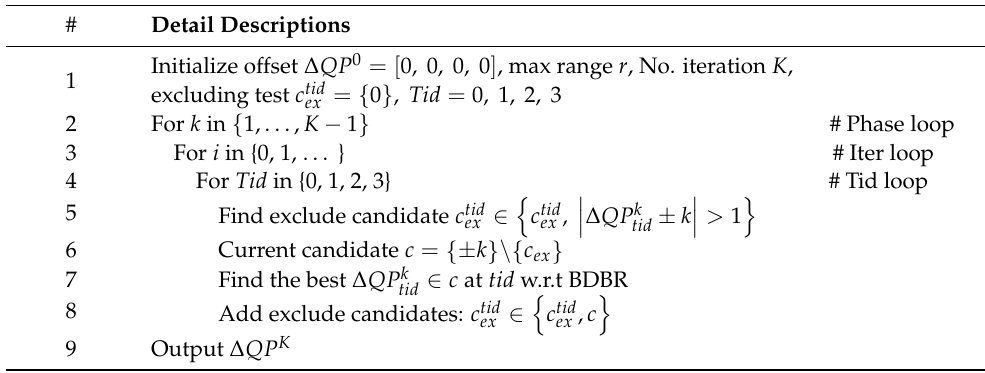
Algorithm 1 Proposed trellis-based bitrate allocation